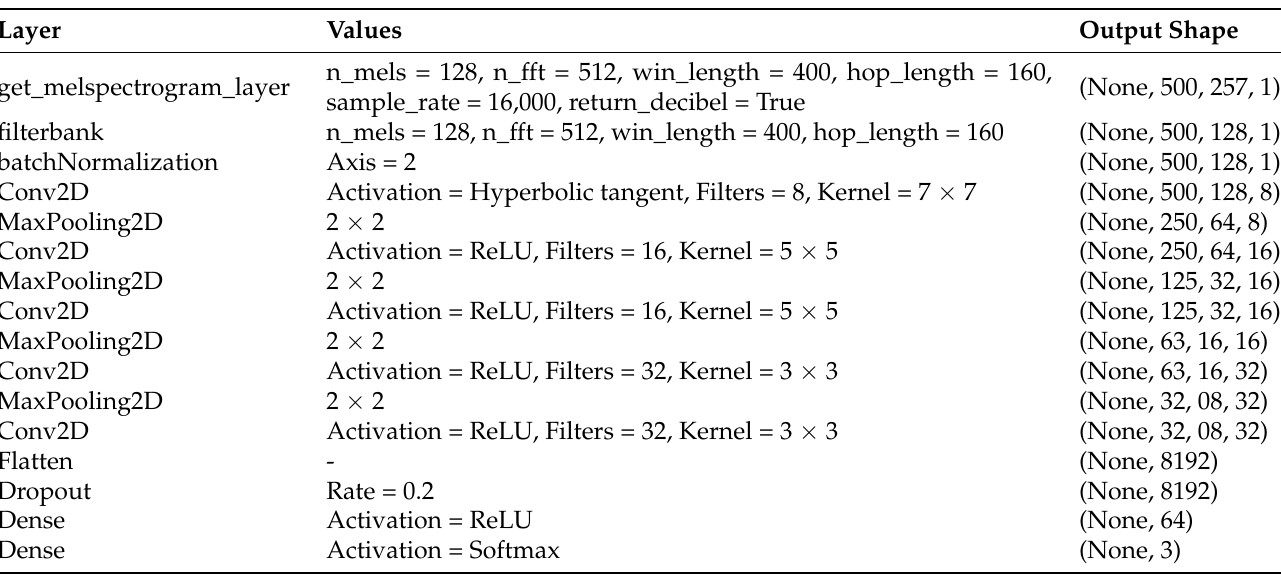
Table 13. Layers detail of Conv2D model.